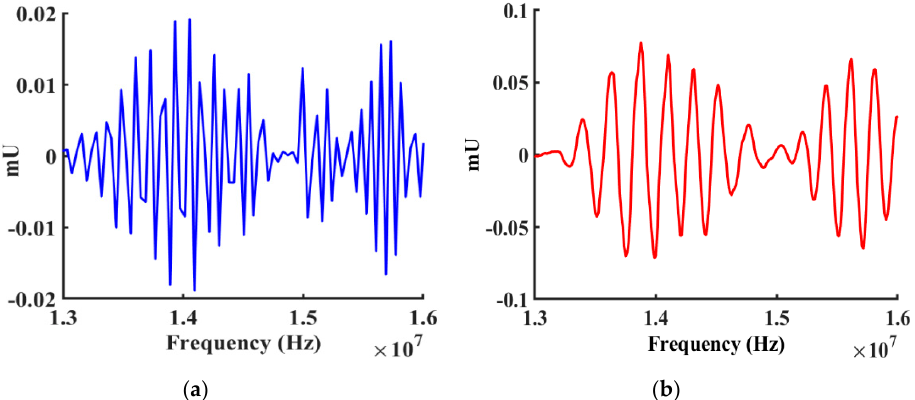
Figure 10. Comparison between simulated (Blue) and measured (Red) phase angle responses from the device (with Cr IDTs only).